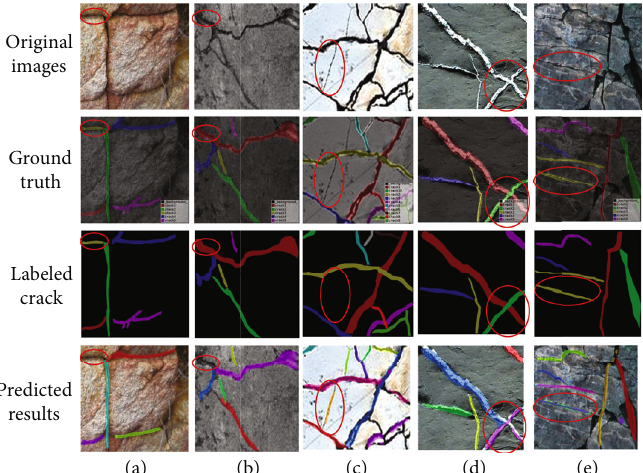
Figure 16: Examples of falsely detected situations indicated in red circles. (a) Omitting of crack detection at the edge of the image; (b) missing part of the crack at the edge of the image; (c) providing potential crack detections that are not labelled in the ground truth; (d) inaccurate segmentation when overlapping happens at the edge of the images; and (e) providing redundant predictions on the same crack.